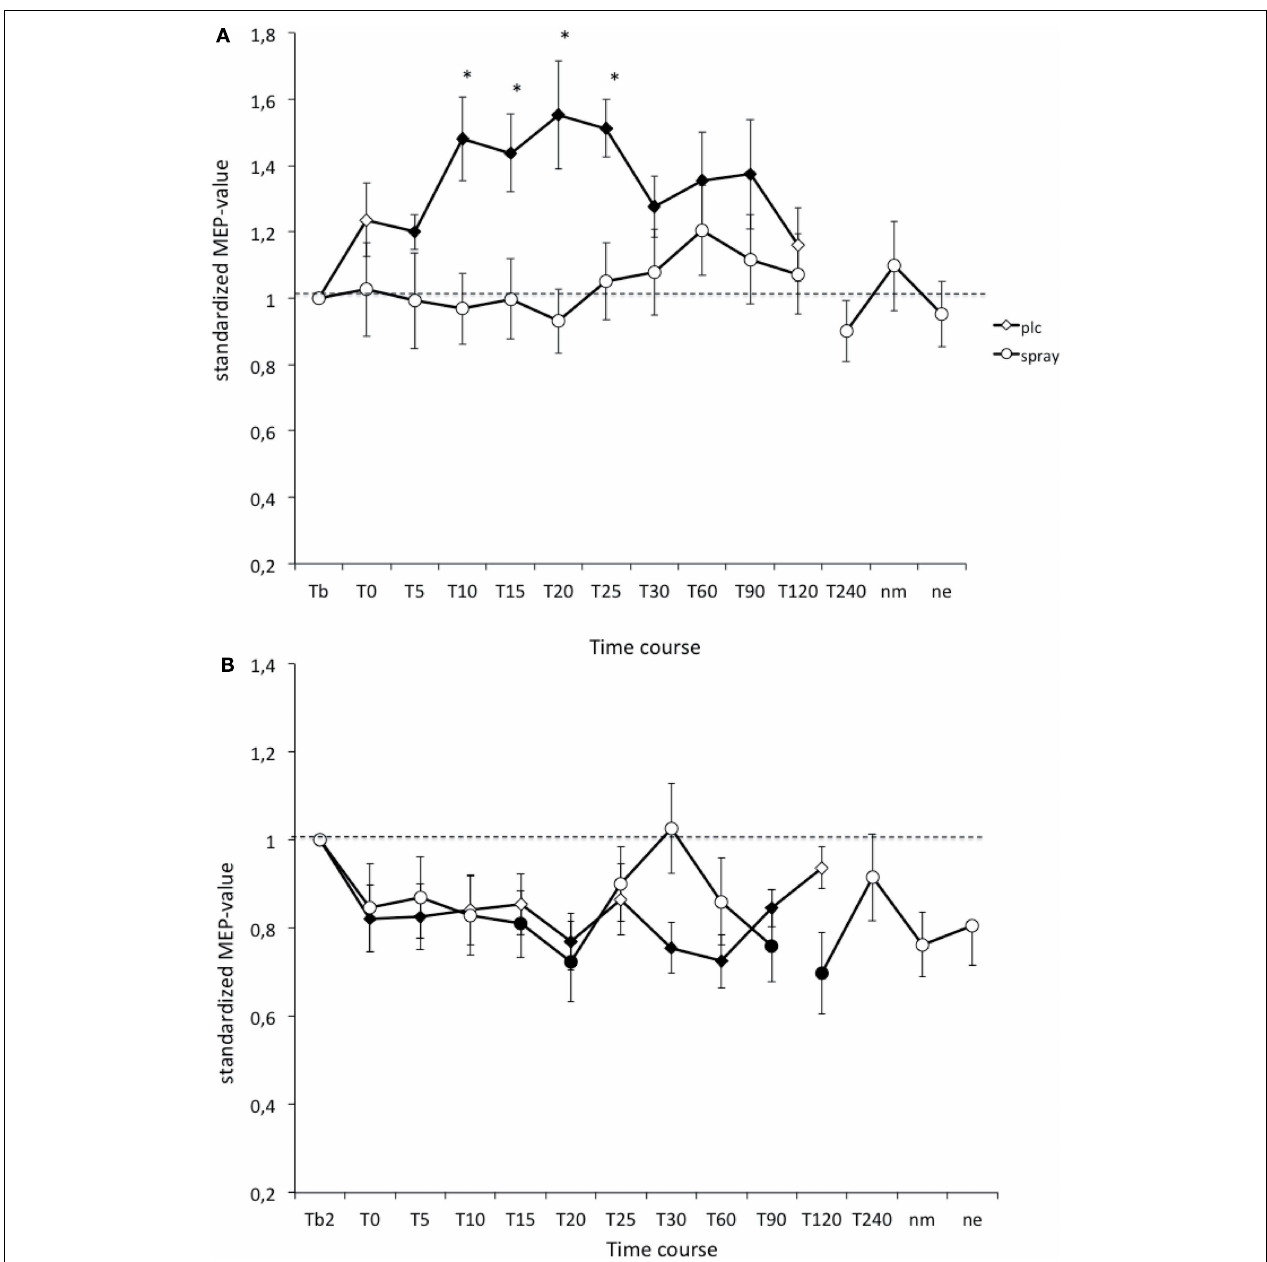
asterisks indicate significant differences between the control and nicotine conditions (Student’s t -test, paired, two-tailed, p < 0.05). nm, Next morning; ne, next evening; plc, placebo.Tb, Baseline MEP-amplitude before begin of the stimulation protocols (standardized). Error bars indicate standard error of